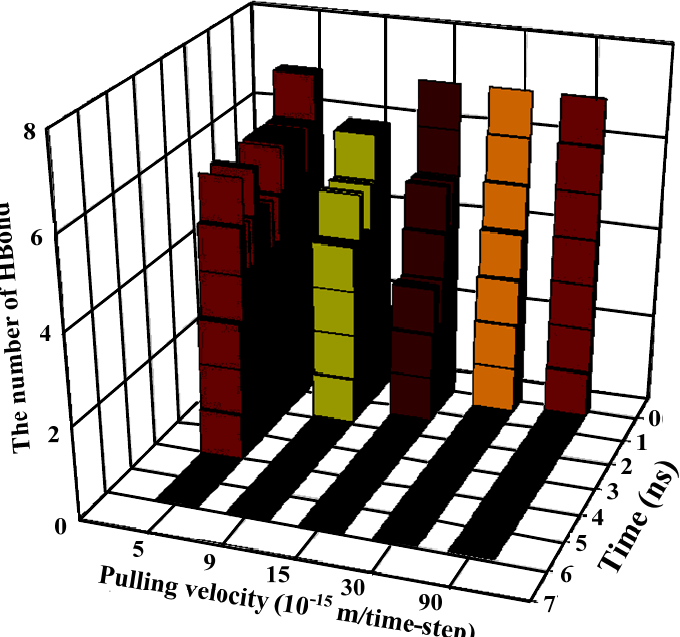
Figure 4. Calculating the amount of inter-molecular hydrogen bonds from pulling rates: